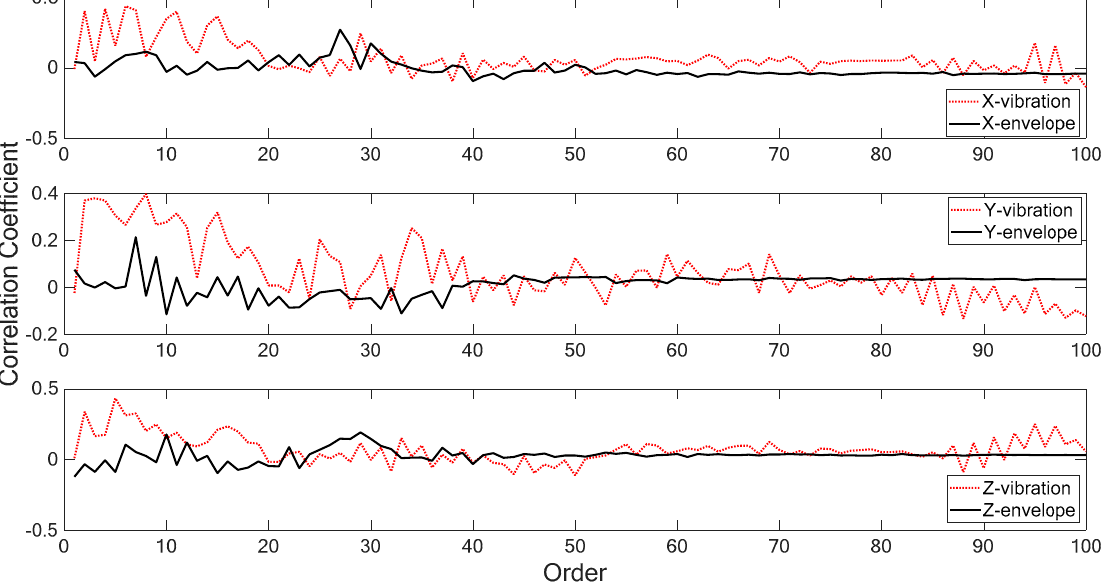
Figure 6. Correlation coefficients of order spectra of spindle vibration signals and their corresponding envelopes with respect to Ra values.